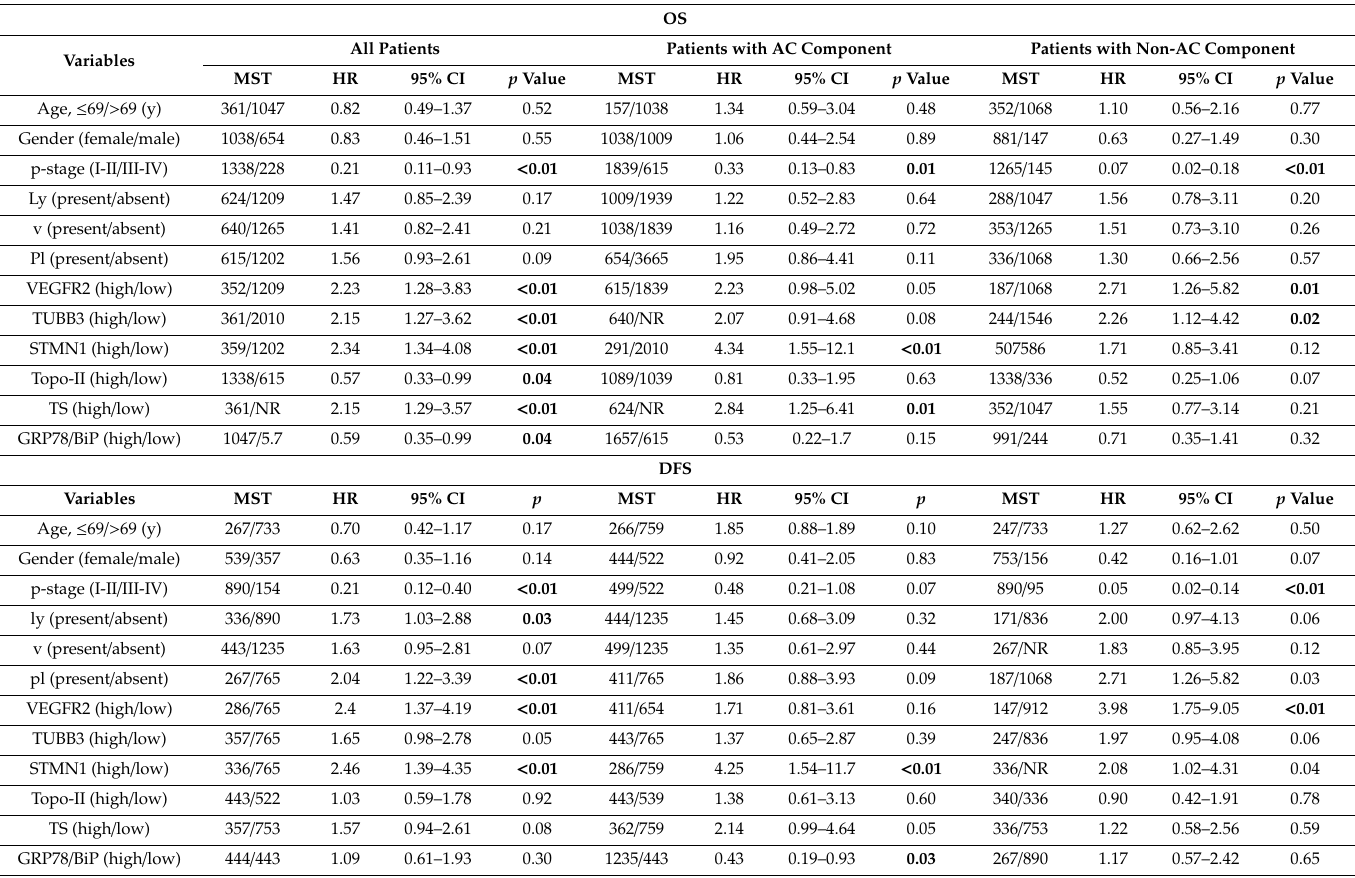
Table 3. The univariate disease-free survival (DFS) and overall survival (OS) analyses. OS All Patients Patients with AC Component Patients with Non-AC